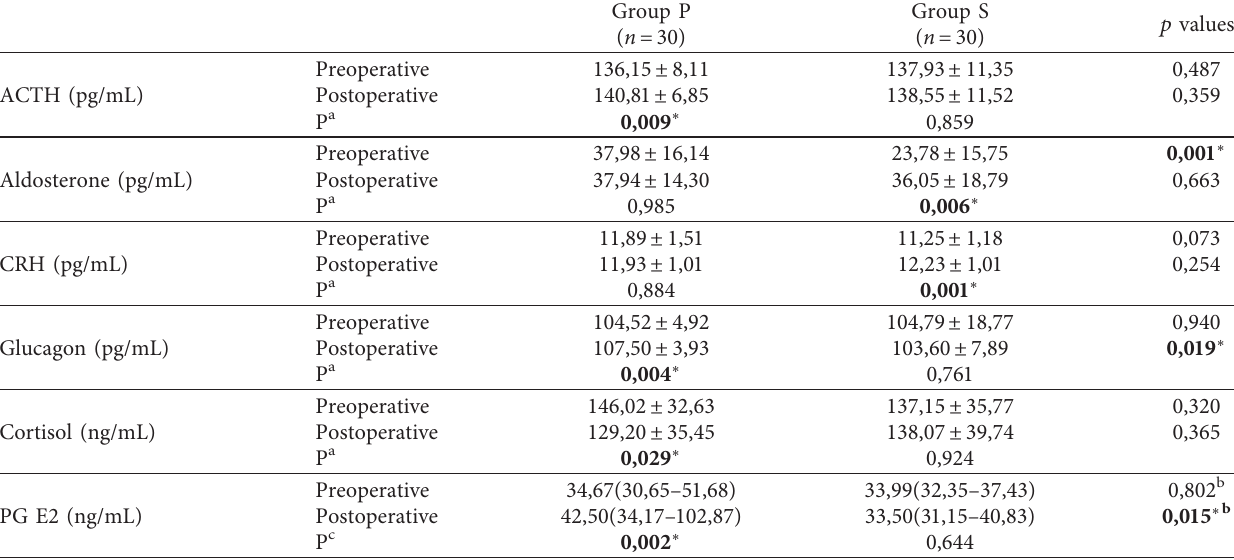
Table 2: Between-group and intragroup comparisons of blood parameters between groups P and S.